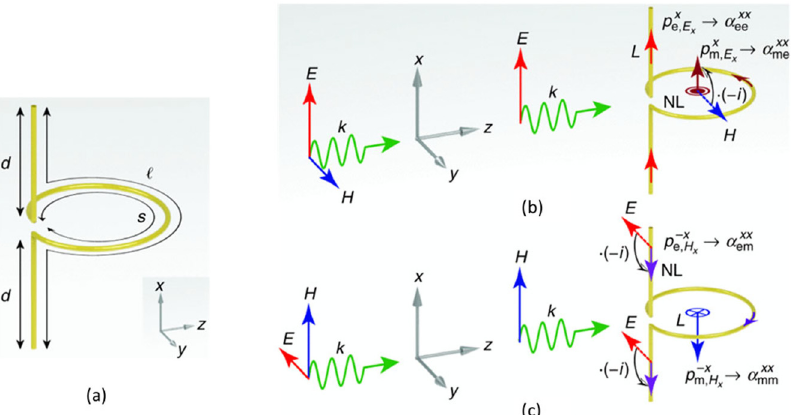
Figure 6: Chiral bianisotropic particle (reprinted with permission from Ref. [61]). (a) The Chiral bianisotropic particle geometry. (b) Induced dipole moments underelectricexcitation.(c)Induceddipole moments under magnetic excitation.